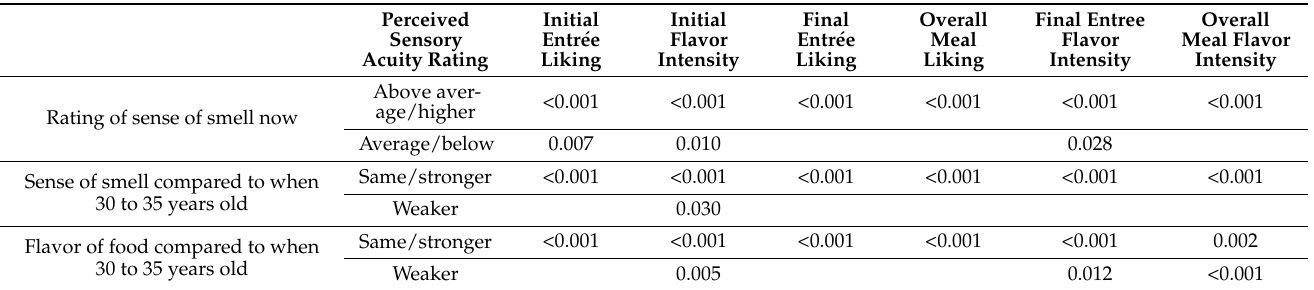
Table 6. V meal; p values for significant differences between NS and S versions on liking and perceived flavor intensity with sensory acuity within a subgroup. There was no significant interaction (moderation) effect except for flavor of food vs. liking entr é e rating. Participants gave higher ratings for S version than for NS for each